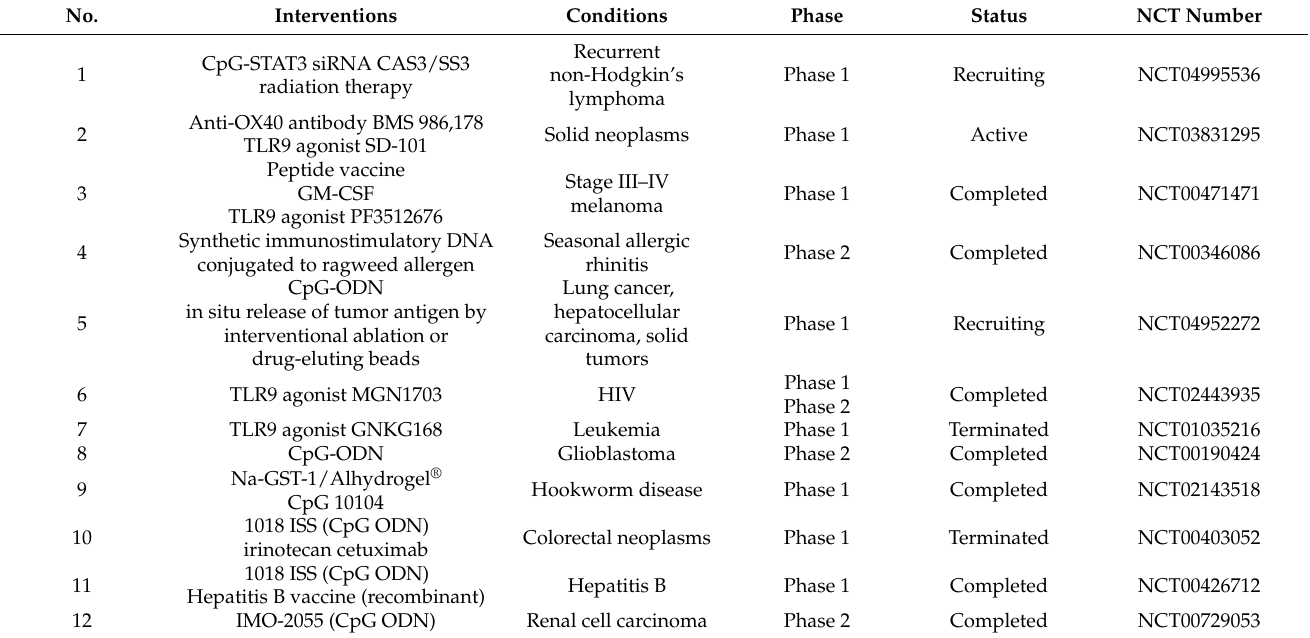
Table 3. Ongoing and completed clinical trials exploring CpG